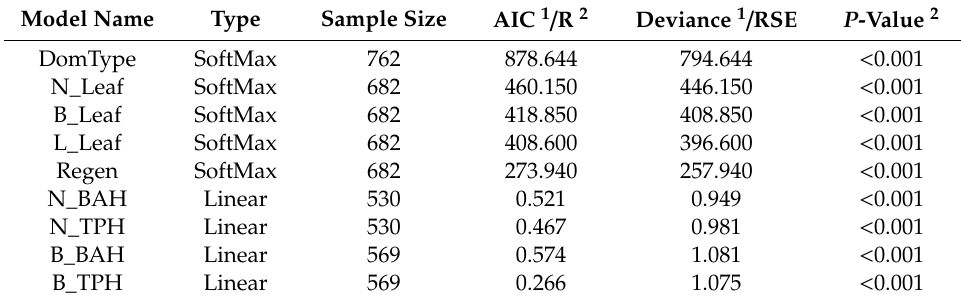
Table 2. Model name, type, sample size and fit statistics for each model in the